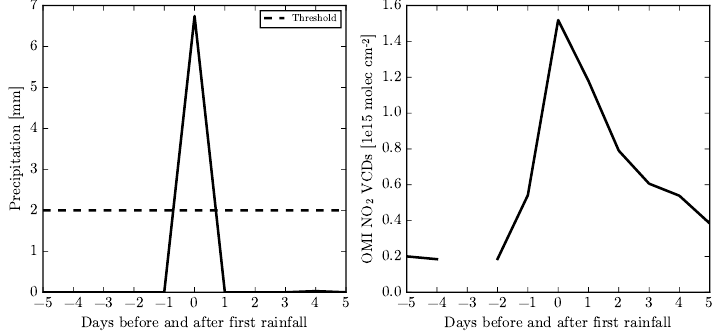
Figure 2. Time series of TMPA precipitation (a) and OMI NO 2 VCDs (b) for a 10 day period around the first rain event for a single grid pixel in the Sahel on 11 April 2008 at 15.25 ◦ N, 25.5 ◦ E. A threshold of 2mm precipitation per day is chosen and at least 60 days of drought are